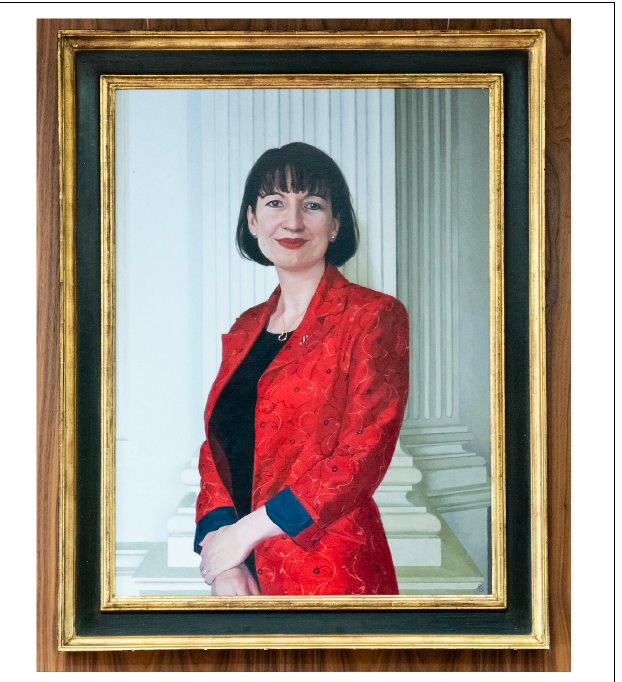
FIGURE 2 | Dr. Suzy Lishman,